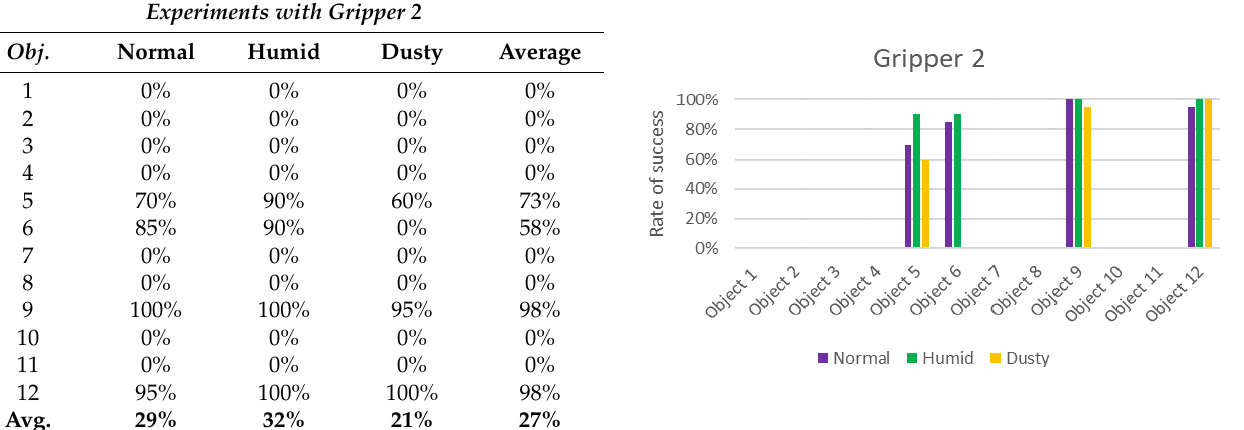
Table 3. Experiments with Gripper 2. On the left, the table with success rate for every object, in the last column, the average for every object is calculated, and at the end of the table, the average success rate for every environment is determined. On the right, the graphic representation of Table 3 is reported.